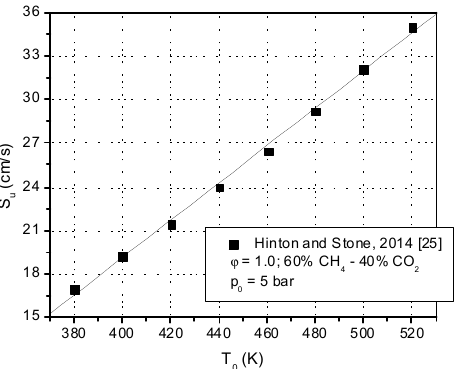
Figure 10. Initial temperature influence on experimental laminar burning velocity for stoichiometric equivalence ratio and 5 bar initial pressure.